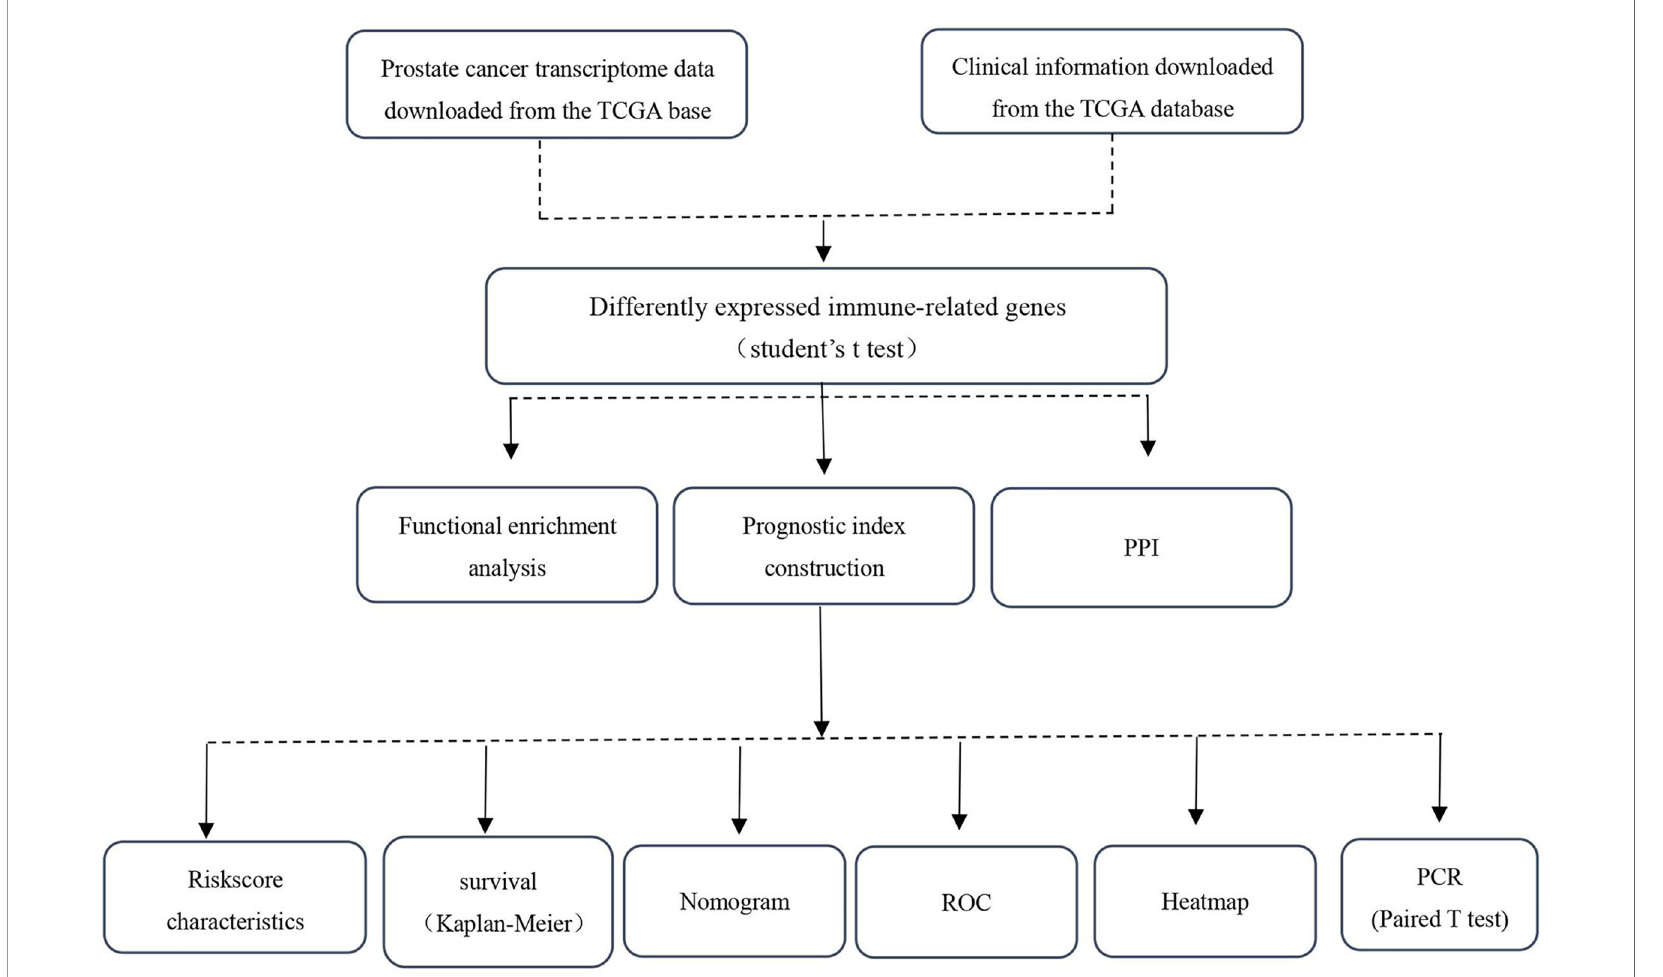
FIGURE 1 | Research work fl